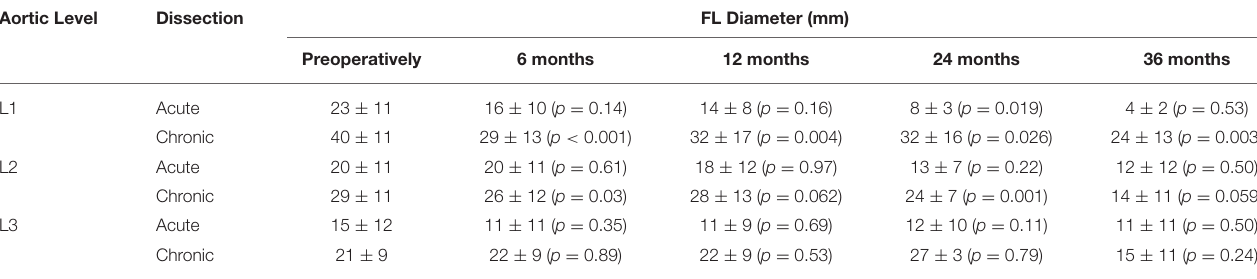
TABLE 1 | Summary of TL diameter results from Berger et al. (Thoraflex Hybrid) (15). Aortic Level